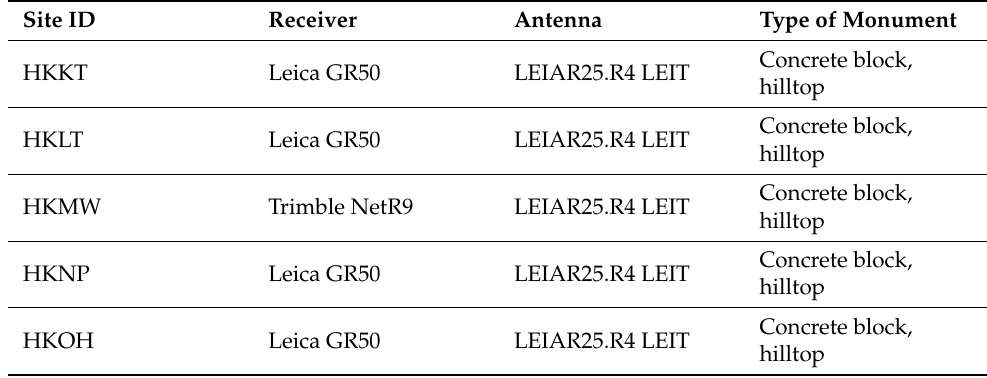
Table 3. Station information for the Hong Kong SatRef stations (stations are arranged by the type of